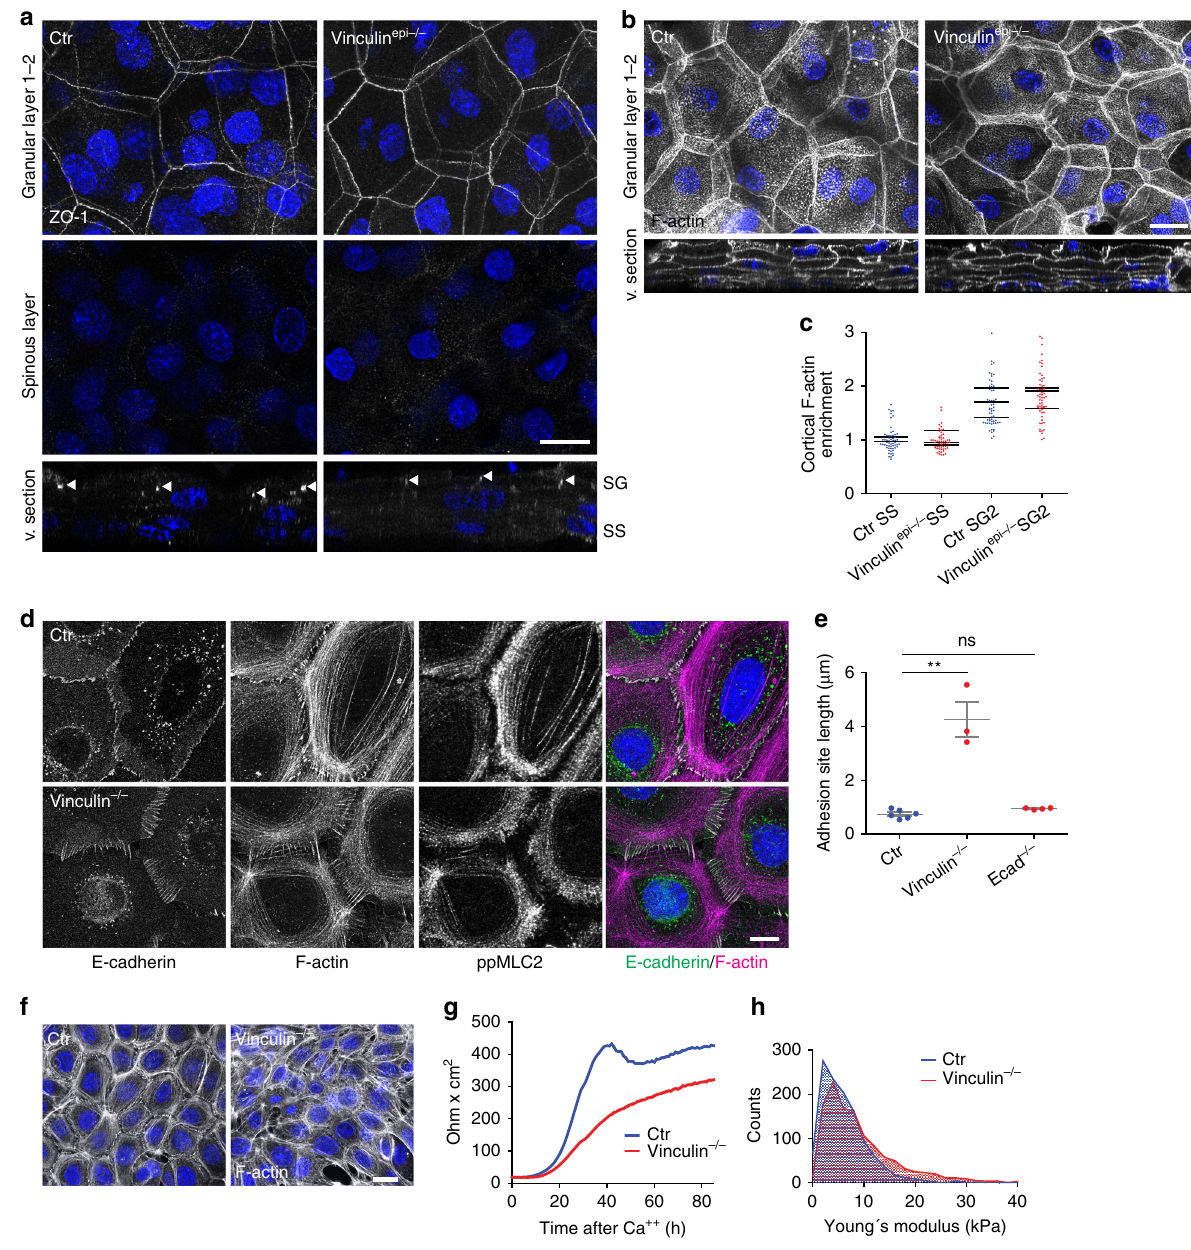
Fig. 6 Vinculin is not essential for junctional tissue polarization. a Newborn epidermal whole-mount fl uorescence analysis for ZO-1 showing its distribution in granular layer 2 (SG2), spinous layer (SS), and cross section (v. section). b Newborn epidermal whole-mount fl uorescence analysis for phalloidin showing F-actin organization in SG2 and in all epidermal layers (v. section). a , b Partial confocal stack (deconvolved) projections and virtual section (v. section). Nuclei stained with DAPI (blue). Scale bars, 20 µ m. c Quanti fi cation of layer speci fi c cortical actin enrichment normalized to Ctr SS,